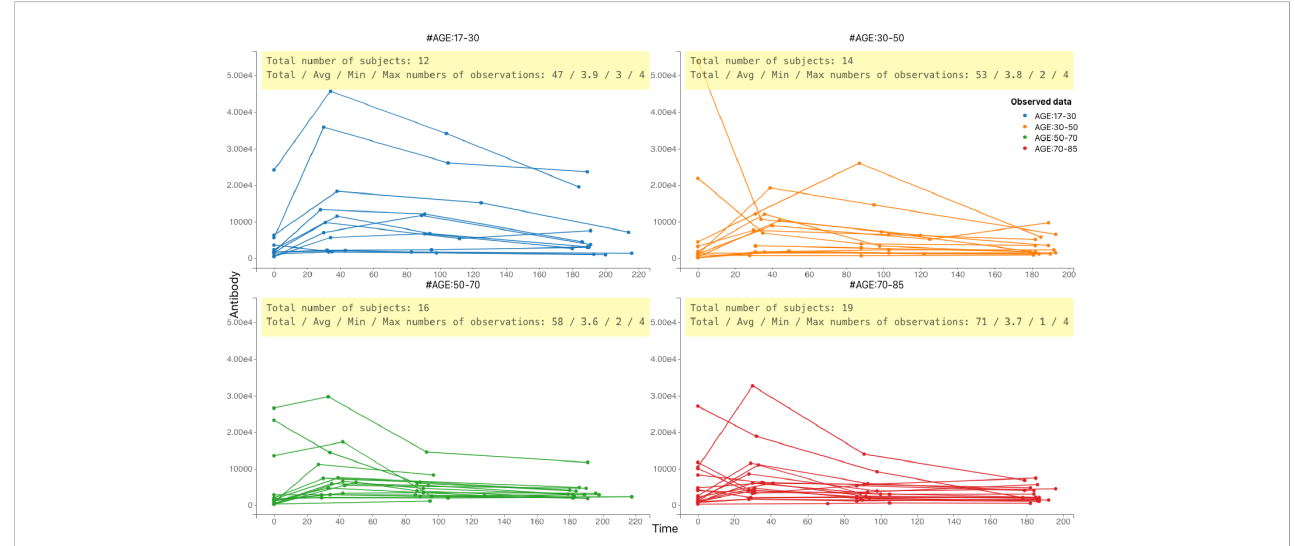
FIGURE 1 Individual-speci fi c VZV IgG antibody titer concentration (expressed in mIU/ml) pro fi les by time (in days) since symptom onset in 61 herpes zoster patients. Data are shown per age